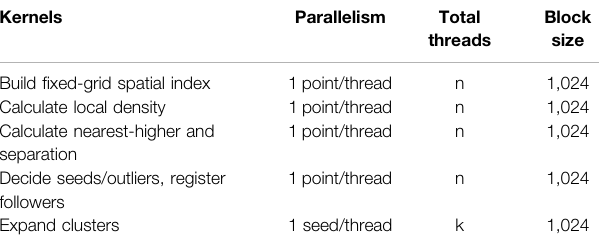
TABLE 2 | Kernels and parallelism.